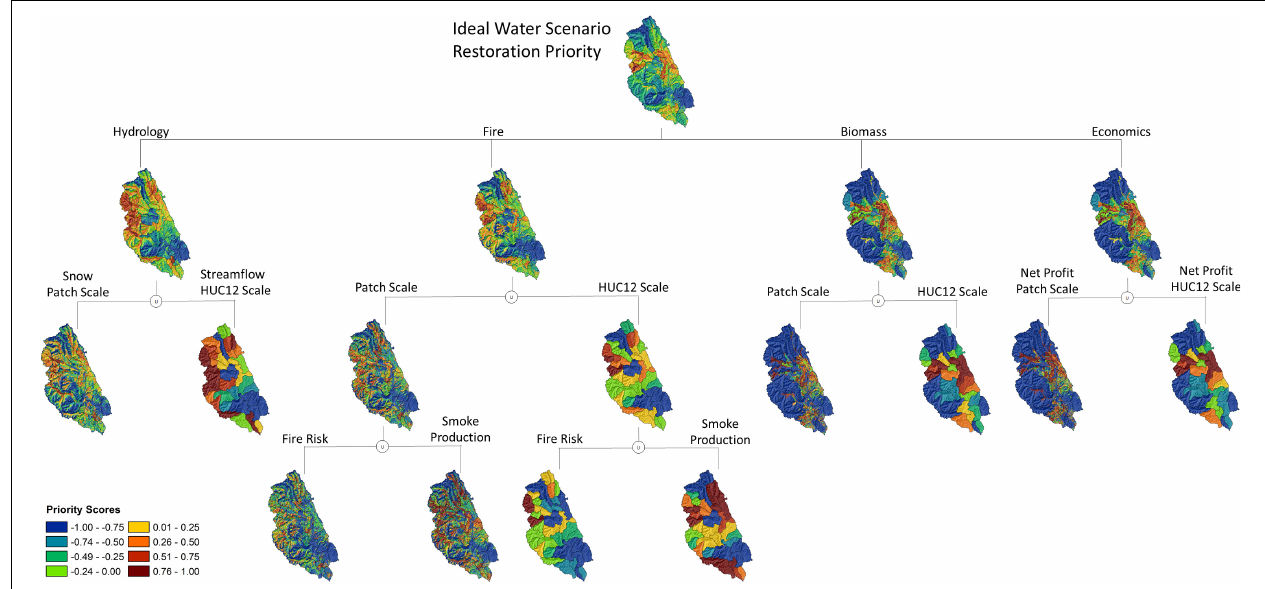
FIGURE 4 | Full DST model results for the IdealWater treatment scenario. Note that the warm colors indicate priority watersheds (HUC-12 scale) and patches (Patch scale) for increasing snow capture, melt out date, and improved flows that are consistent with the land management allocation. Cooler colors indicate lower treatment